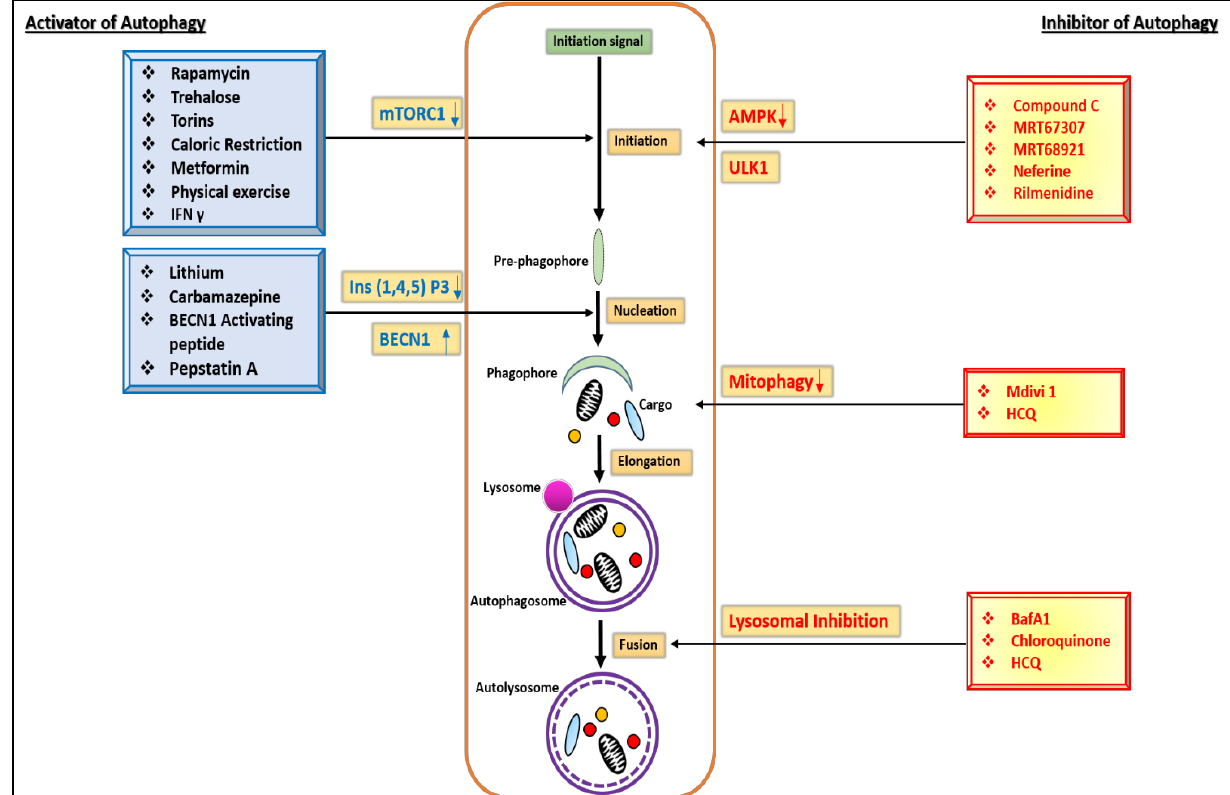
Figure 3. Pharmacological modulators of autophagy including activators and inhibitors at different steps of autophagy . Table 1. Therapeutic effects and modes of action of autophagy modulators in relation to polyQ dis- eases.